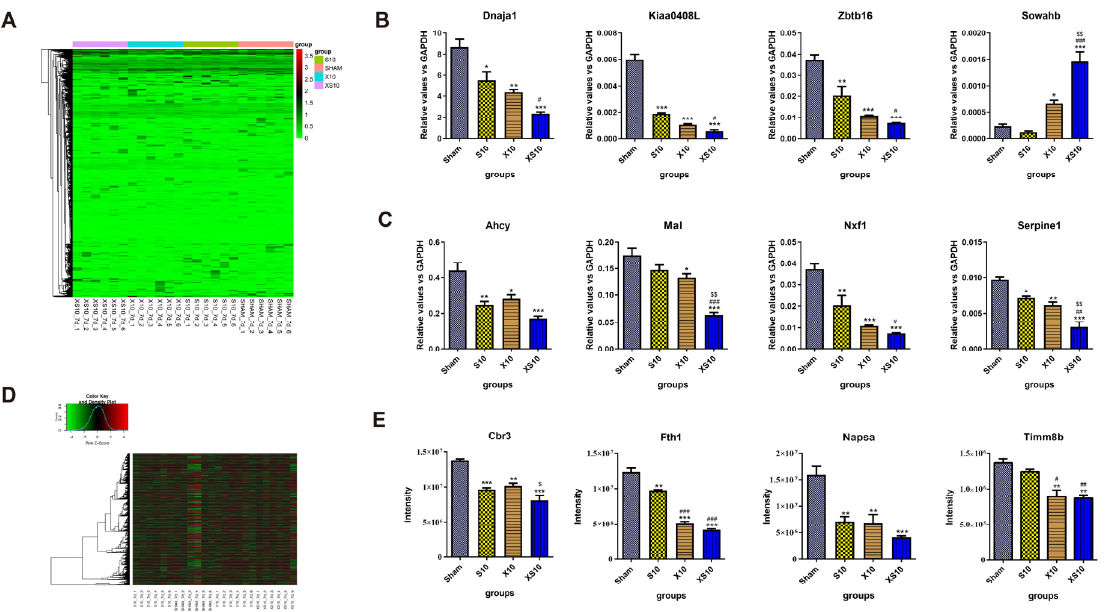
Figure 5. Transcriptomic and proteomic analysis of the spleen at 7 d after multifrequency microwave exposure. At 7 d after microwave exposure, the rats were euthanized, and the spleens were removed from the Sham, S10, X10 and XS10 groups. ( A–C ) Transcriptomics analysis. Total RNA was extracted by TRIzol reagent and RNA sequencing was performed using Illumina NovaSeq, and the DEGs were analyzed as described above ( A ). The mRNA expression levels of four DEGs were verified by qRT-PCR ( B ), and four other immune activity-associated genes were also measured by qRT-PCR ( C ). ( D , E ) Proteomics analysis. The proteins were extracted from the spleens. After the spectral library was constructed, the DEPs were analyzed by DDA mode ( D ). The protein expression of four DEPs was verified by mass spectrometry ( E ). Data are shown as mean ± s.e.m.; *, p < 0.05, **, p < 0.01, ***, p < 0.001 vs. Sham group; #, p < 0.05, ##, p < 0.01, ###, p < 0.001 vs. S10 group; $, p < 0.05, $$, p < 0.01 vs. X10 group. Table 2. The number of differentially expressed genes and proteins in the spleen after exposure to multifrequency microwaves of 2.8 GHz and 9.3 GHz. Number of DEGs Number of DEPs Groups Upregulated Downregulated Upregulated Downregulated S10 vs.